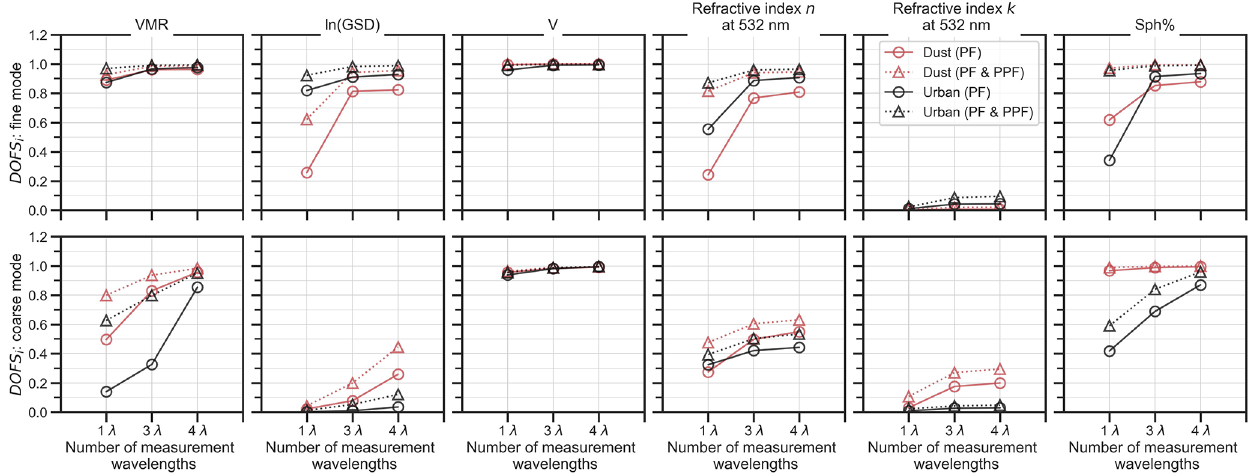
Figure 6. DOFS i values for specific aerosol parameters corresponding to the fine (upper row) and coarse (bottom row) bimodal non-spherical- aerosol model with a priori variance values based on results from Espinosa et al.